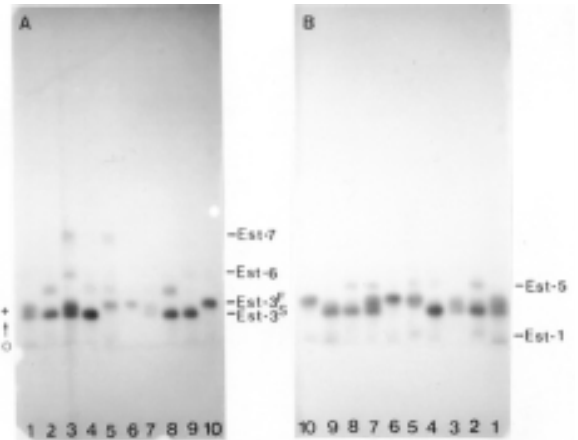
Figure 2 - Isoesterases of Diatraea saccharalis pupae on starch gel and Tris/citratebuffer,pH7.0showingallelicvariationforthe Est-3 locusinA ( α -naphthylacetate)andB( β -naphthyl-acetate).Samples1,3and7corre- spond to the Est-3 F/S isozyme phenotype, samples 2, 4, 8 and 9 correspond to the Est-3 S/S isozyme phenotype, and samples 5, 6 and 10 correspond to the Est-3 F/F isozyme